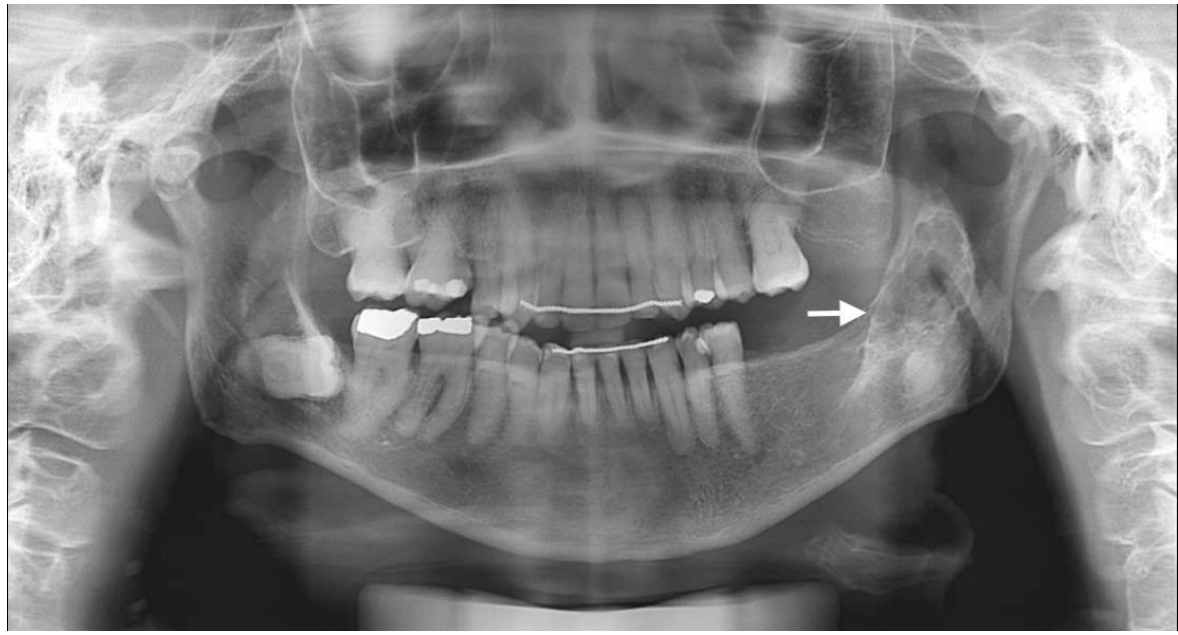
Figure 1. Preoperative panoramic radiographic image. Radiolucency with many radiopaque spots described as driven snow appearance. No association with impacted teeth was seen (see arrow).